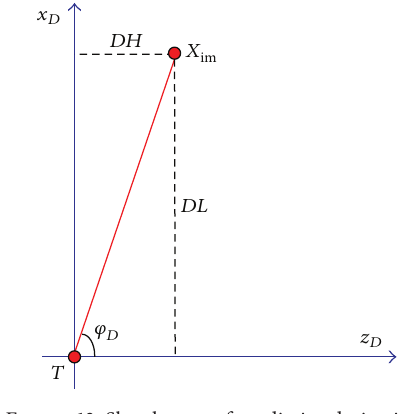
Figure 13: Sketch map of predictive derivation.